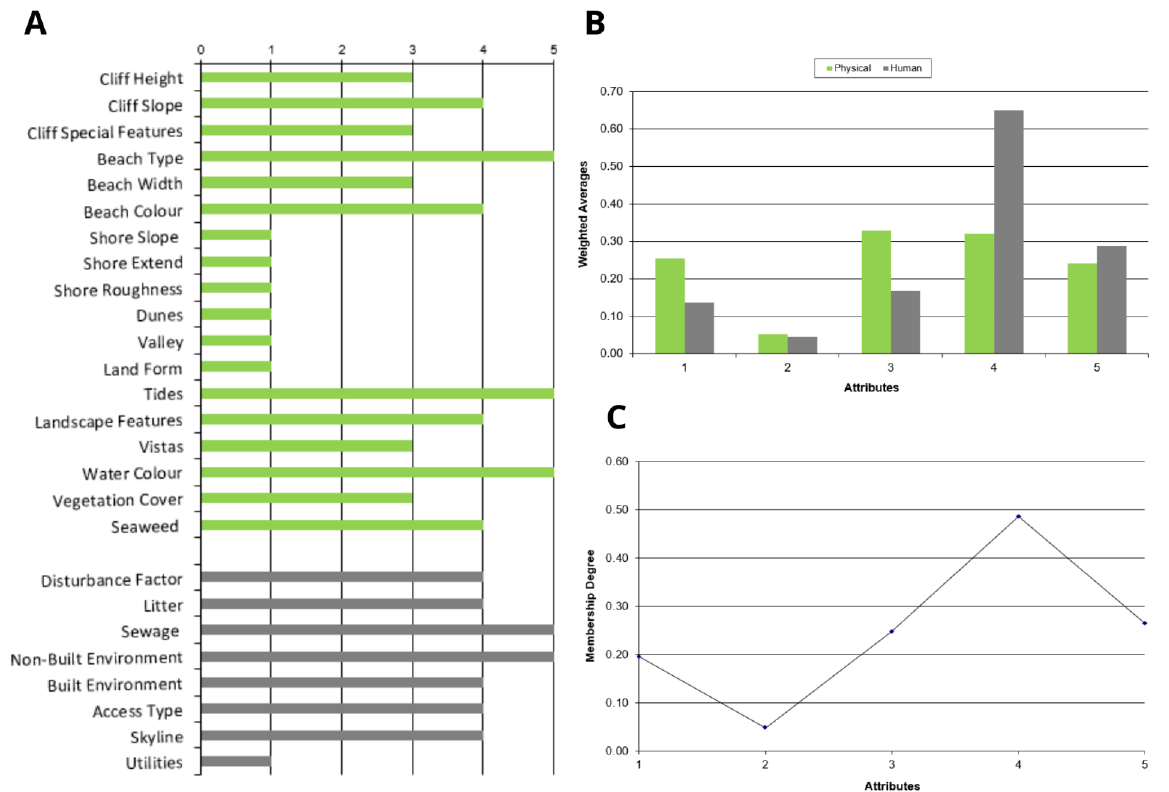
Figure 6. CSES parameters ratings for Cala d’Hort, Ibiza (D: 0.64; class III) ( A ), weighted averages vs. attributes ( B ) and membership degree vs. attributes ( C ).